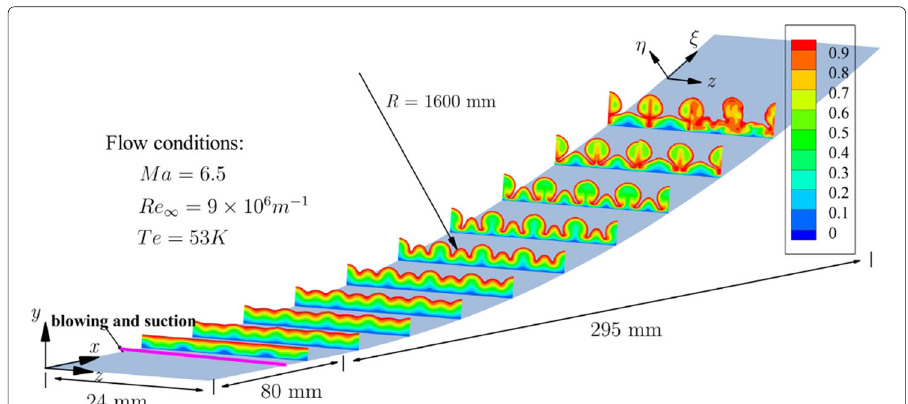
Fig. 1 Sketch of the concave wall and coordinates. Also shown are the nonlinear evolutions of Görtler vortices in the laminar simulation (0 < z < 12 mm) and in the transitional simulation (12 < z < 24 mm) through a sequence of cross sections ranging from x = 65 mm to x = 320 mm with a step of 28 mm. The contours are coloured by the streamwise